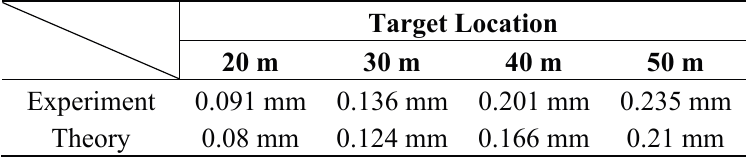
Table 5. Precision comparison of experiment results with theoretical